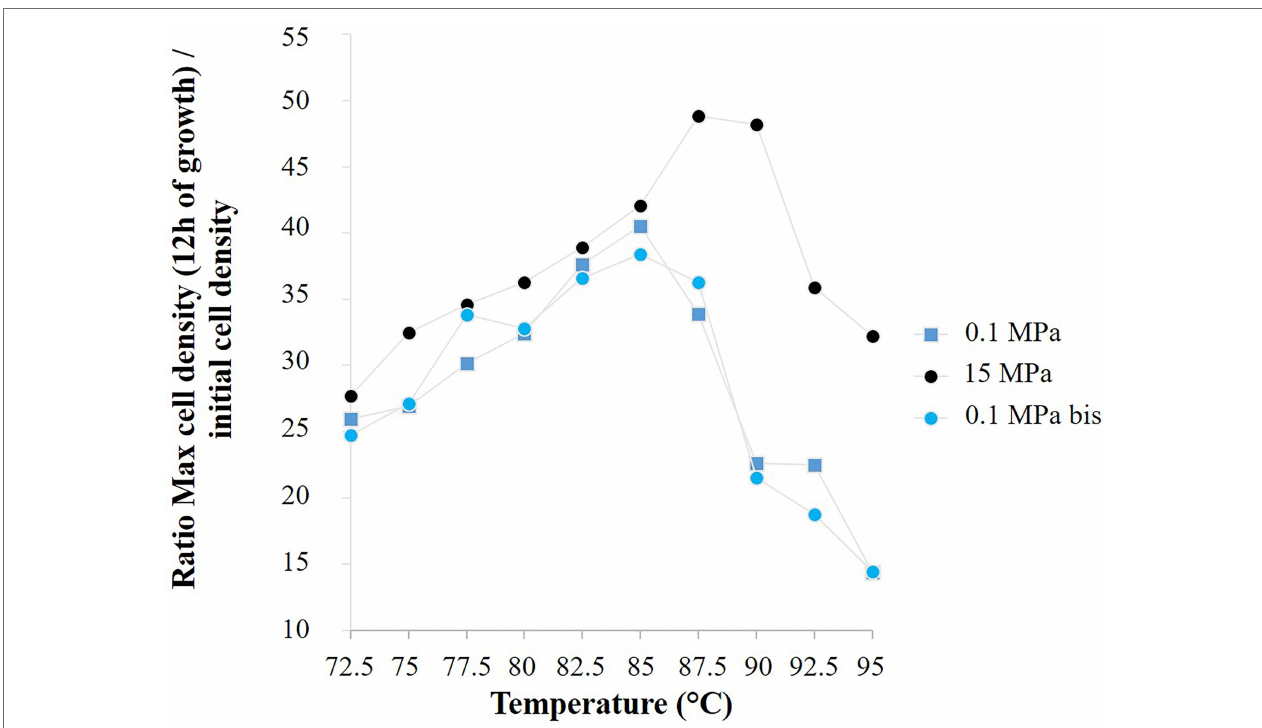
FIGURE 6 | Ratio of the mean cell density of Thermococcus barophilus after 12 h of growth to the corresponding mean initial cell density, for three temperature gradient microfluidic experiments (72.5 ° C–95 ° C): atmospheric pressure (0.1 MPa) in a microchip of 1.5 nl pool volume, both 15 MPa and atmospheric pressure (0.1 MPa bis) in a microchip of 1.9 nl pool